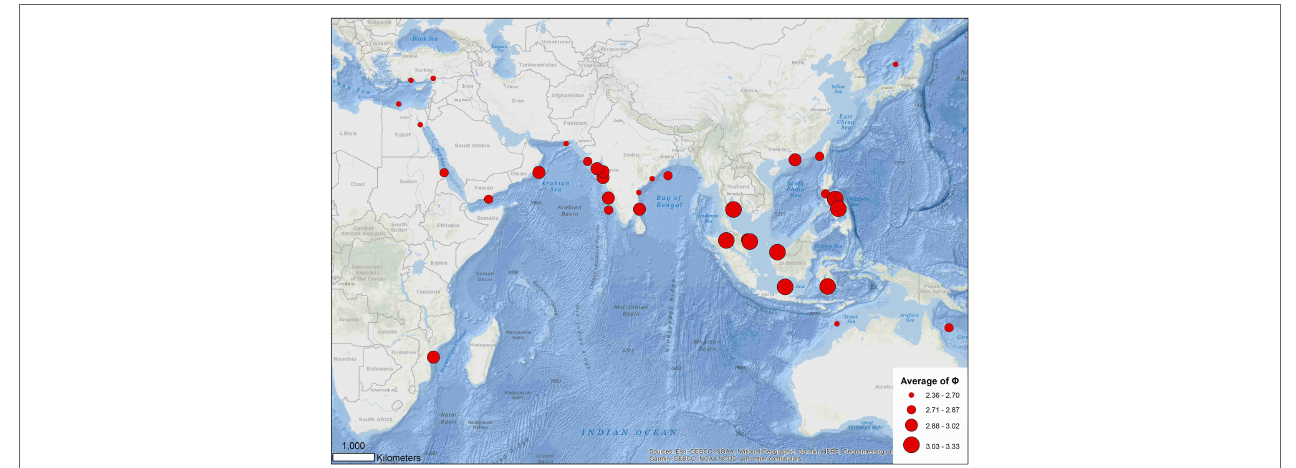
FIGURE 8 | Distribution of average growth performance index ( φ ) of global growth parameter estimates for brushtooth lizardfish.